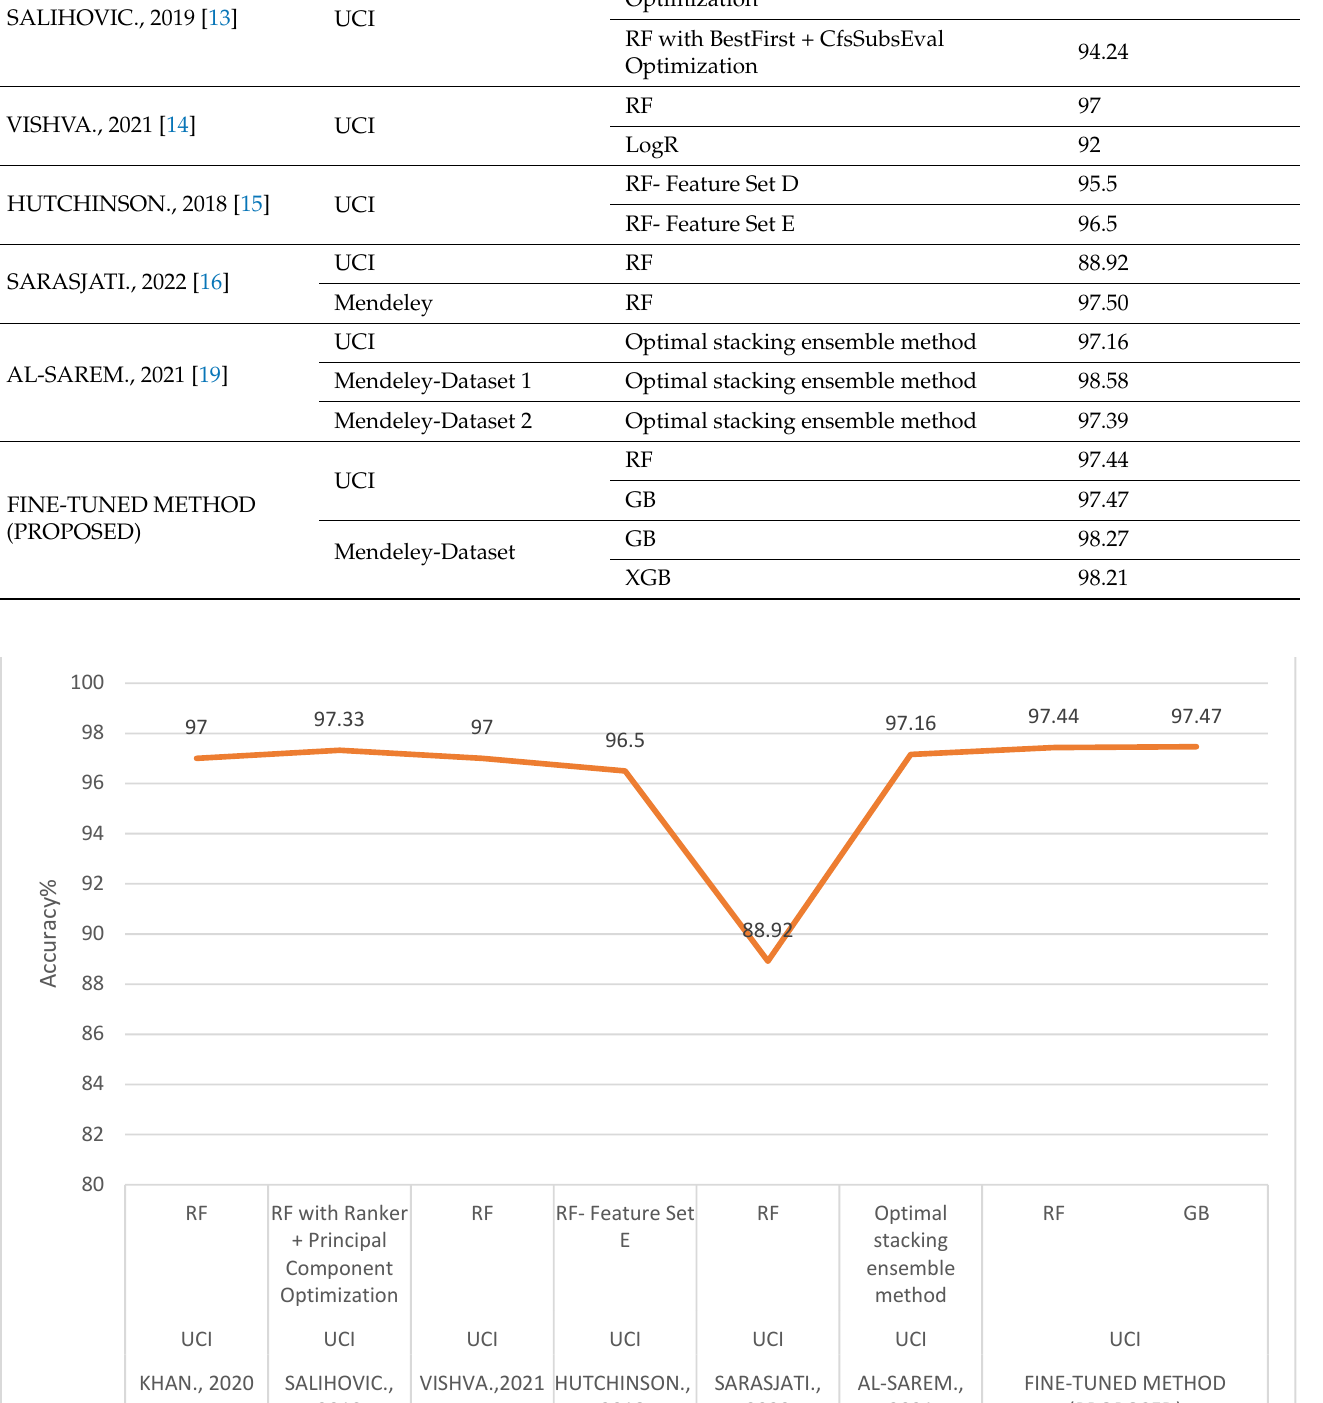
Figure 11. Performance comparison of existing and fine-tuned method for Mendeley dataset [16,19].